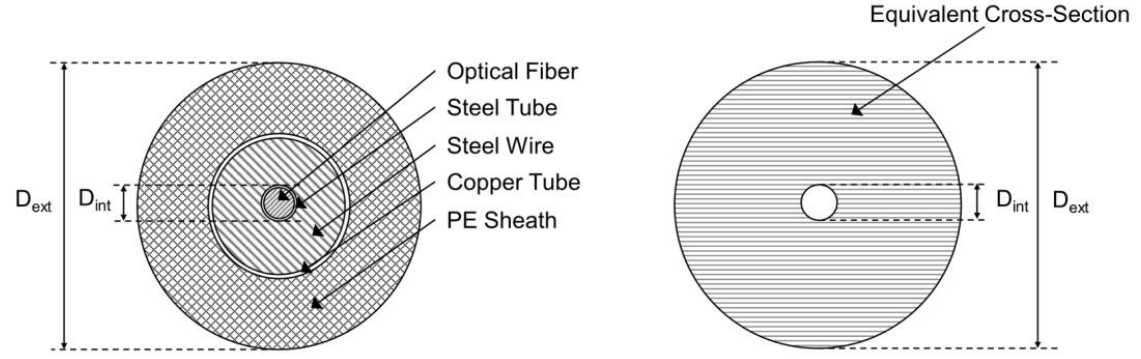
Figure 3. LW submarine cable and its equivalent cross-section.